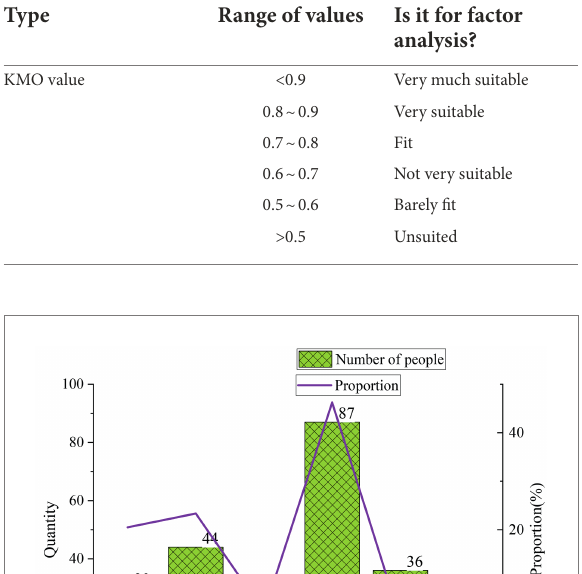
Vocabulary is the most basic part of English learning. From Figure 8, in terms of mastering pronunciation, spelling, and basic meaning, 50.39 and 35.24% of respondents either have mastered